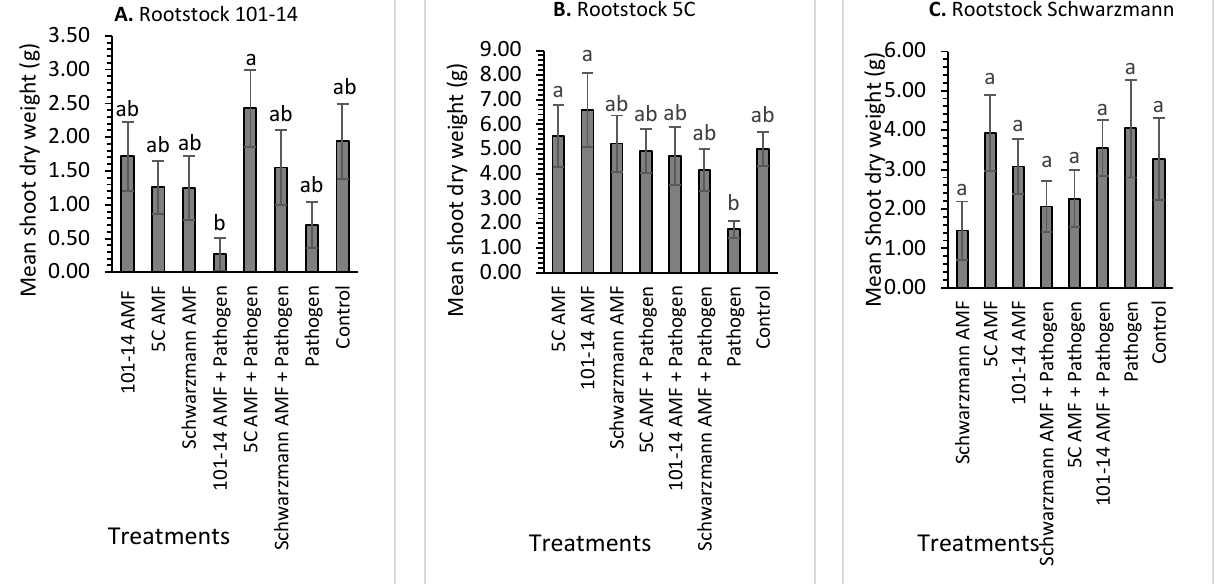
Figure 2. Mean shoot dry weight (g) at harvest for rootstocks 101-14 ( A ), 5C ( B ) and Schwarzmann ( C ) colonized with different AMF communities originating from different rootstocks (101-14, 5C and Schwarzmann) and inoculated with black foot pathogen isolates. Bars with different letters are significantly different ( p ≤ 0.05) based on the SED of mean comparisons generated from one-way ANOVA analysis in R. Error bars show ± SED.